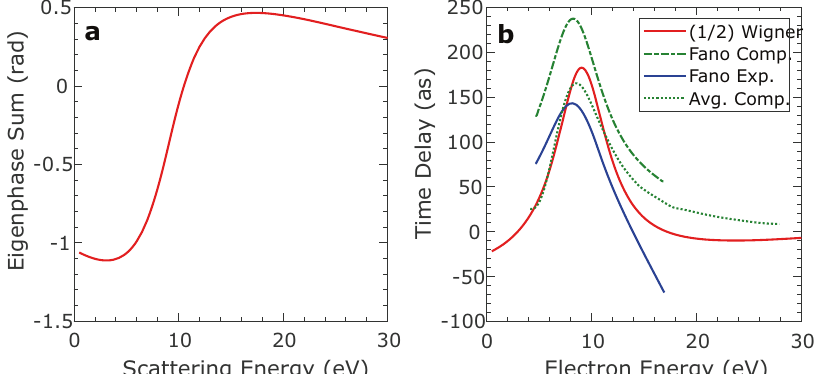
Fig. 5 Eigenphase sum and Wigner time delay for scattering from NO + . Eigenphase sum for e-NO + scattering from a one-channel calculation including only the c 3 Π state of NO + , with the electron-kinetic energies given relative to the threshold for that state ( a ). One channel (1/2) τ Wigner time delay for the short-range part of the scattering phase shift compared to the photoionization time delays extracted from the resonant part of the multichannel Fano fi t for theory and experiment as presented in Fig. 4e, and to the computed emission angle averaged ionization delay for the parallel orientation (see text) ( b